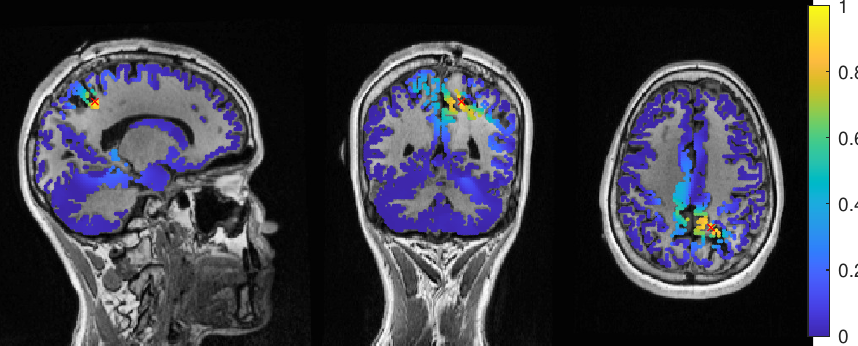
Figure 5. Patient 1’s result of the MEG event-related beamformer in the 6 compartment head model at 0.05 regularization with sagittal ( left subfigure), coronal ( middle subfigure), and axial ( right subfigure) cuts through T1 MRI and source space. The maximum is additionally marked with a red x. Note that the MRI is not in radiological